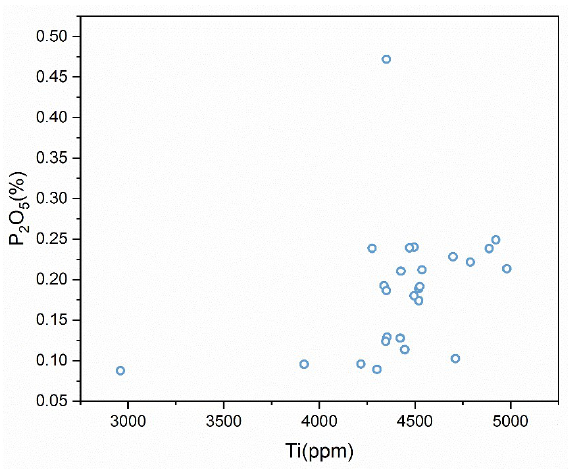
Figure 7. Relationship between P 2 O 5 (%) and Ti (ppm) in the